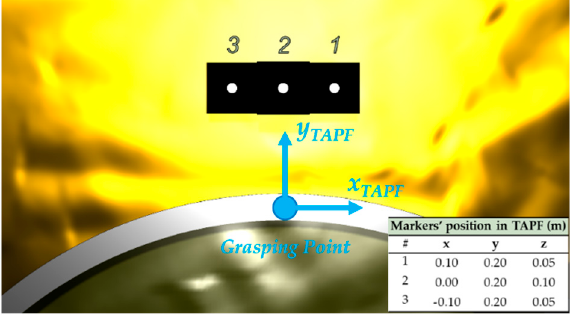
Figure 9. Pattern of markers employed on the target spacecraft for the CSFF arm -TAPF pose estimation, with indication of the position of their centroids in the TAPF.